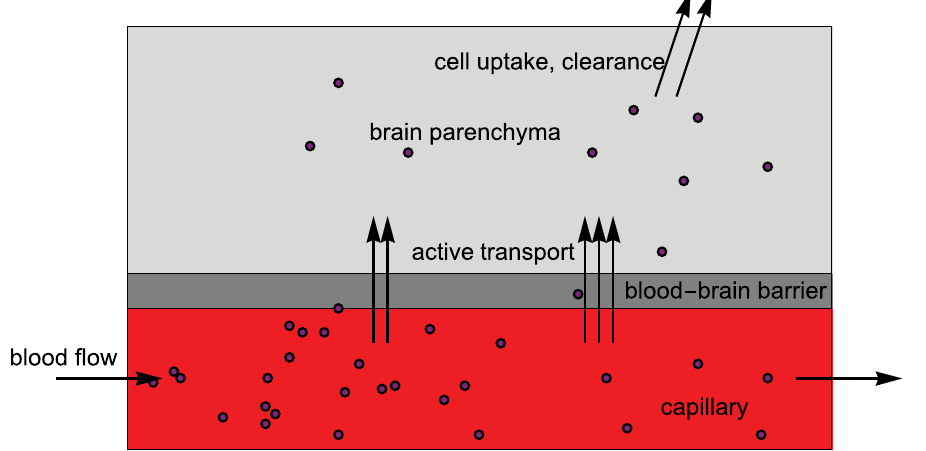
Fig 1. A simplified model for active drug transport within the capillaries, across the BBB and subsequent metabolism. The drug is represented by purple circles.